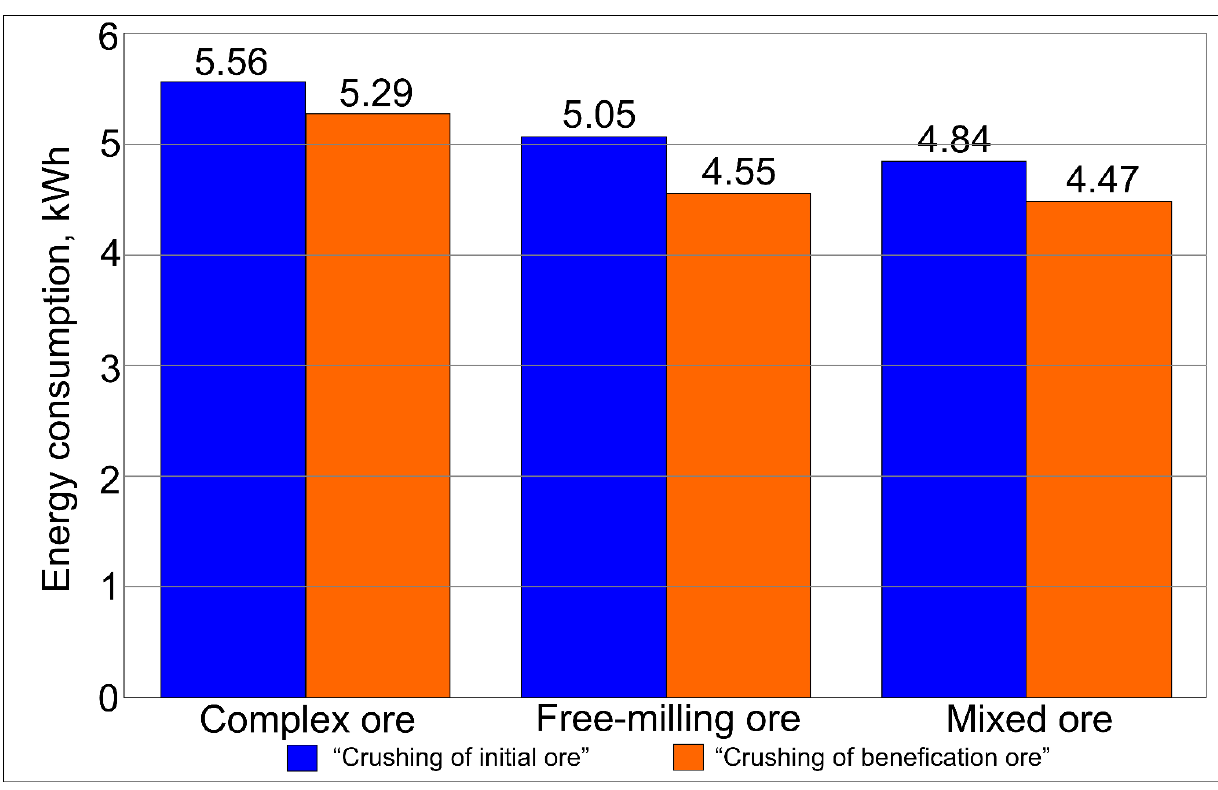
Figure 5. Histograms of energy consumption when crushing the sample material of the initial ore and the magnetic product separated during dry separation.